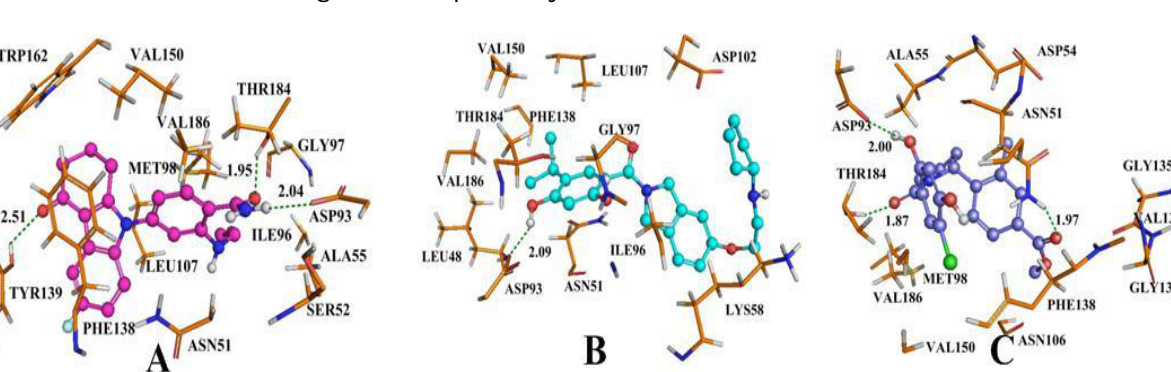
Figure 9. The enlargement for the structure of the binding site with substrates which are displayed in ball and sticks, H-bonds are shown as dotted green lines, and the nonpolar hydrogens were removed for clarity. ( A ) Docked conformation derived for compound 17 in complex to the active site of Hsp90 enzyme; ( B ) Docked conformation derived for compound 24 with the binding site of Hsp90; ( C ) The docking structure of compound 19 with the allosteric binding site of Hsp90